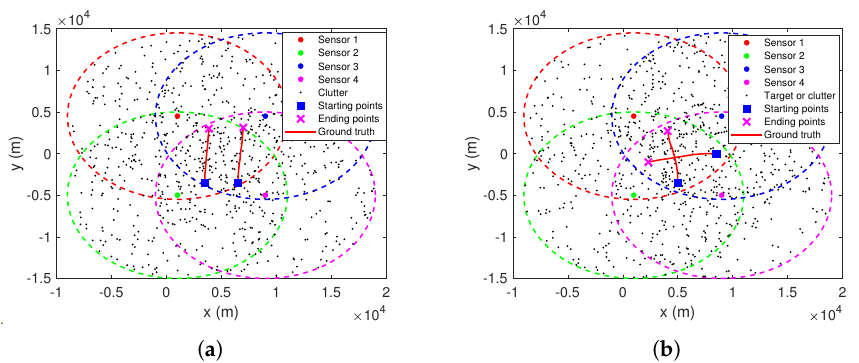
Figure 16. Multitarget tracking scenarios with 4 passive sensors. ( a ) Scenarios 4. ( b ) Scenarios 5.